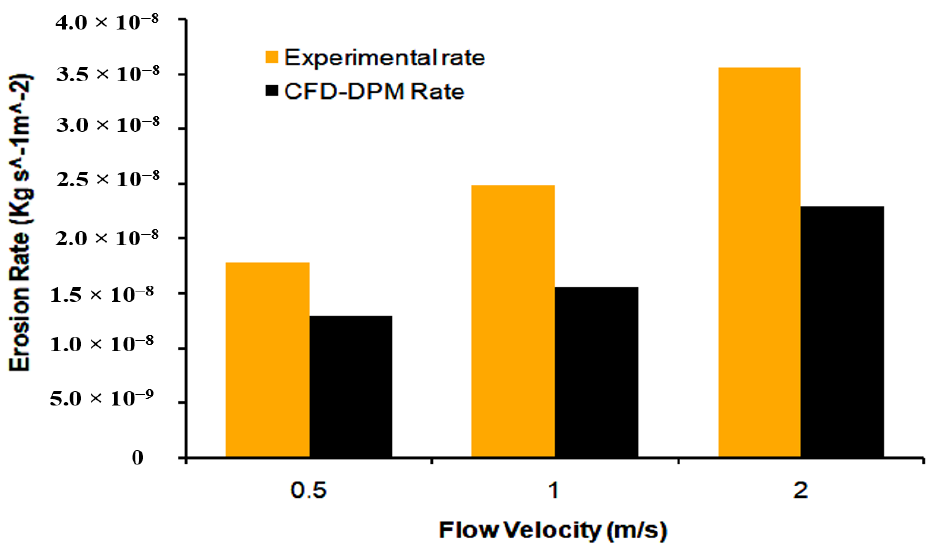
Figure 20. Comparison of predicted erosion rate with the experimental rate of 90-degree elbow for different flow velocities. Table 5. rates of tested 90-degree elbows 1018 CS for liquid-solid flow.